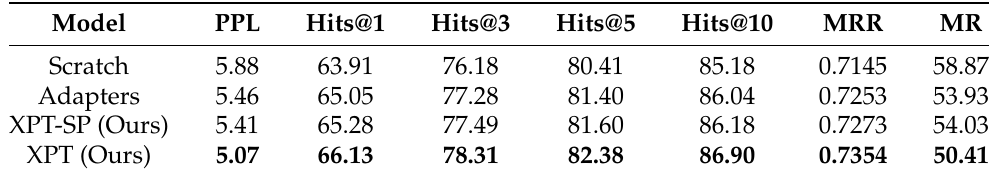
Table 2. Intrinsic evaluation results after using all available 4 million training examples in L 2 . Best values are highlighted in bold. PPL = perplexity. MRR = mean reciprocal rank. MR = mean